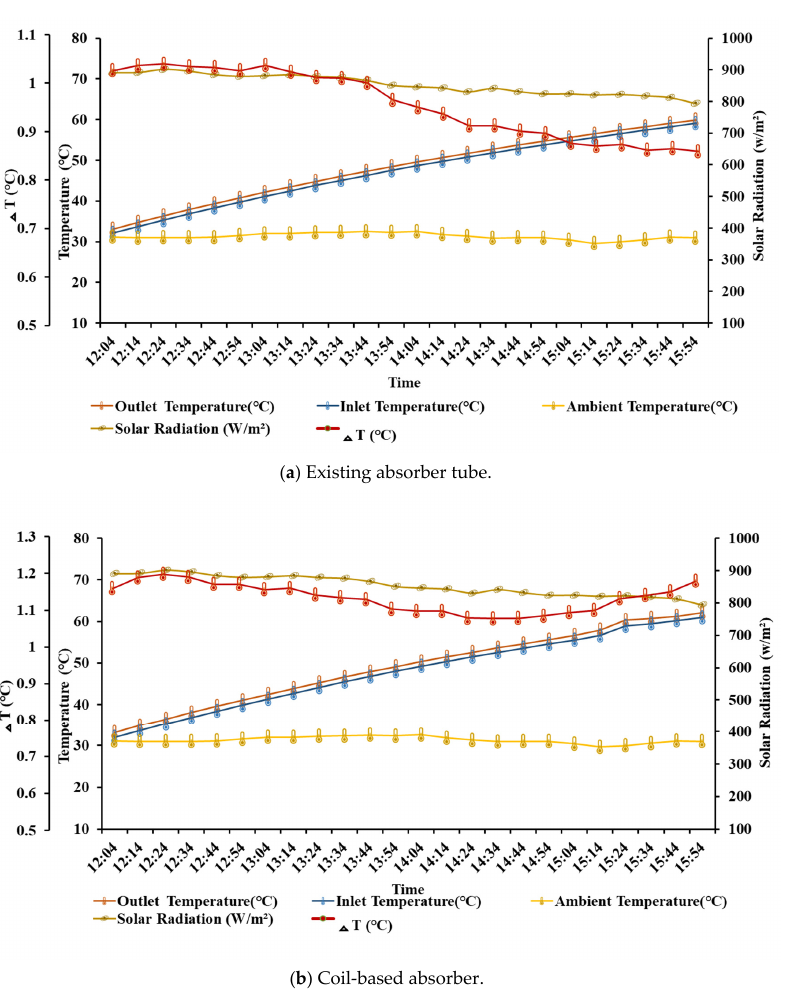
Figure 3. Measured temperature variations and solar radiation in existing absorber tube ( a ) and coil ‐ based absorber ( b ) using distilled water as heating medium (5 June 2020). Similarly, in the case of nanofluid (CuO) as a heating medium, the thermal efficiency of the conical concentrating system was compared with and without coil ‐ based absorbers under similar weather conditions. For the reference case, the solar collector performance was investigated with an existing absorber (without coil) and CuO nanofluid was used as a heating medium at flow rate 6 L/min. Under clear sky conditions, the time ‐ based data of solar radiation, wind speed, and temperature were collected between 10:44 a.m. and 2:32 p.m. on 22 June 2020. the average values of solar radiation and ambient air temper ‐ ature were found to be 832.6 W/m 2 and 35.76 °C, respectively, and the wind speed varied